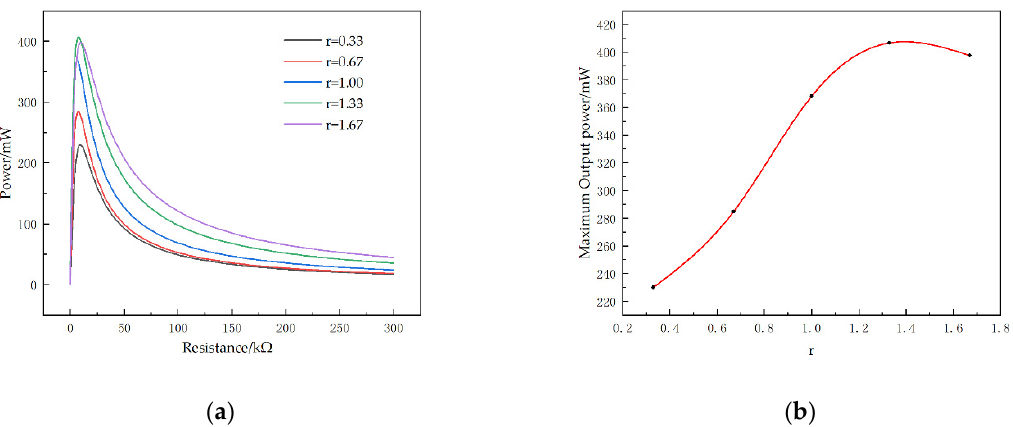
Figure 9. Output power of the STTM-PEH with different piezoelectric patch thicknesses. ( a ) Output power–resistance curves. ( b ) Maximum output power with different r .